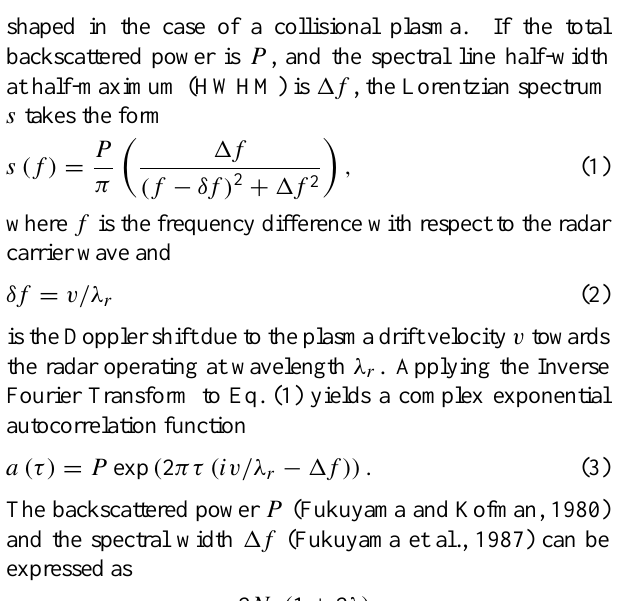
Fig. 4. Modelled IS power and spectral width difference between the 6-s heater-on and heater-off periods as a function of the on-period T e /T n -ratio. The modelling is done for the six cases studied (columns 1–6). First row of panels: relative change of the IS power. Second row: change of the IS power related to ion chemistry change. Third row: relative change of the spectral width. Last row: chemistry part of the spectral width